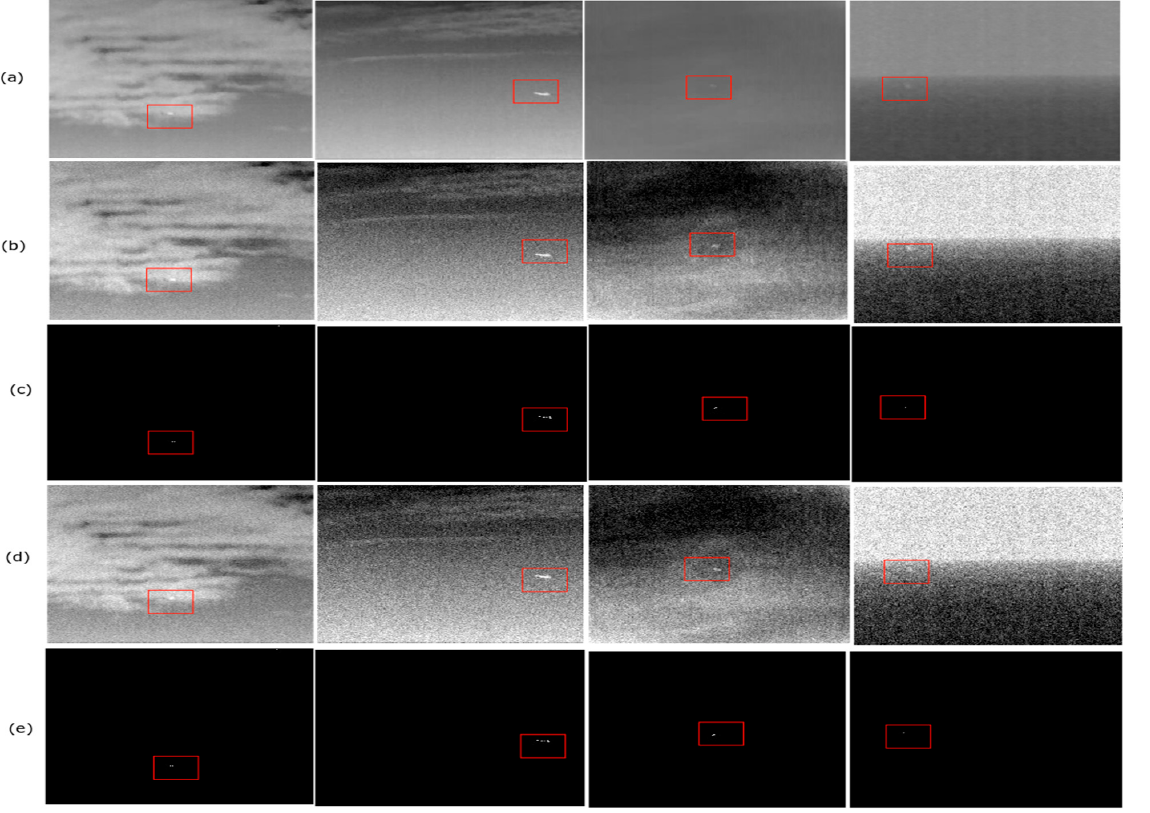
Figure 11. Background suppression results with noise images. ( a ) Original images with noise. ( b ) Noise images with a SD of 10. ( c ) Images after background suppression of Figure 8b. ( d ) Noise images with a SD of 20 ( e ) Images after background suppression of Figure 8c.